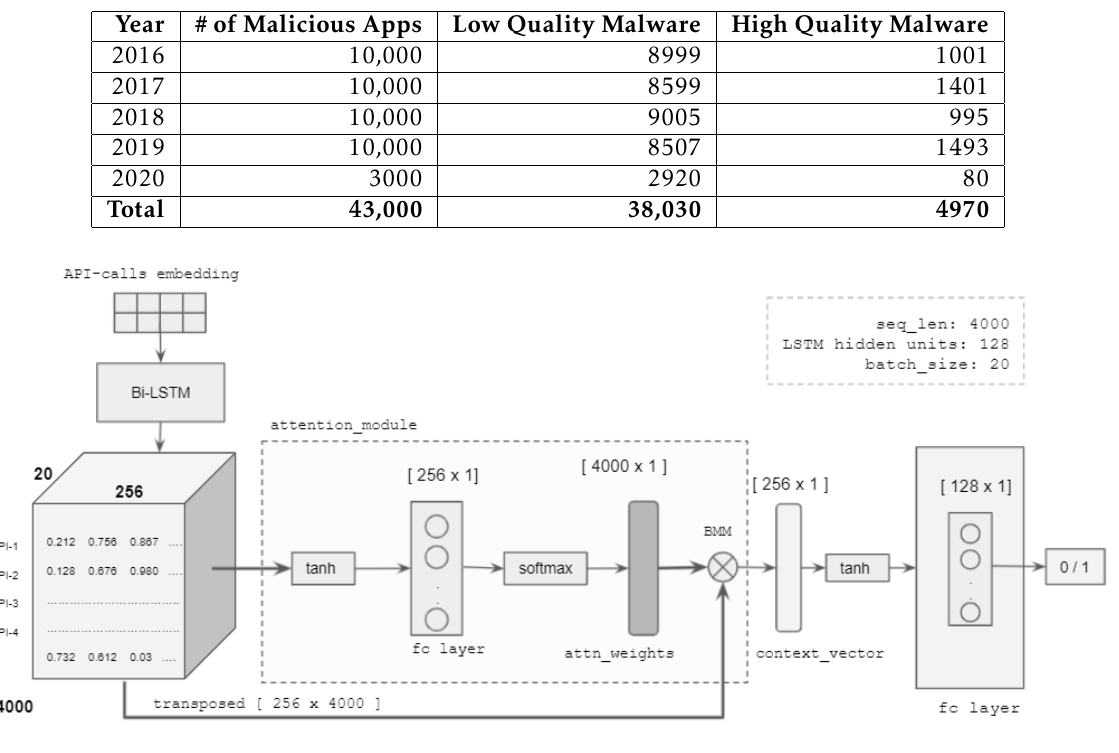
Table 2. The Malicious dataset